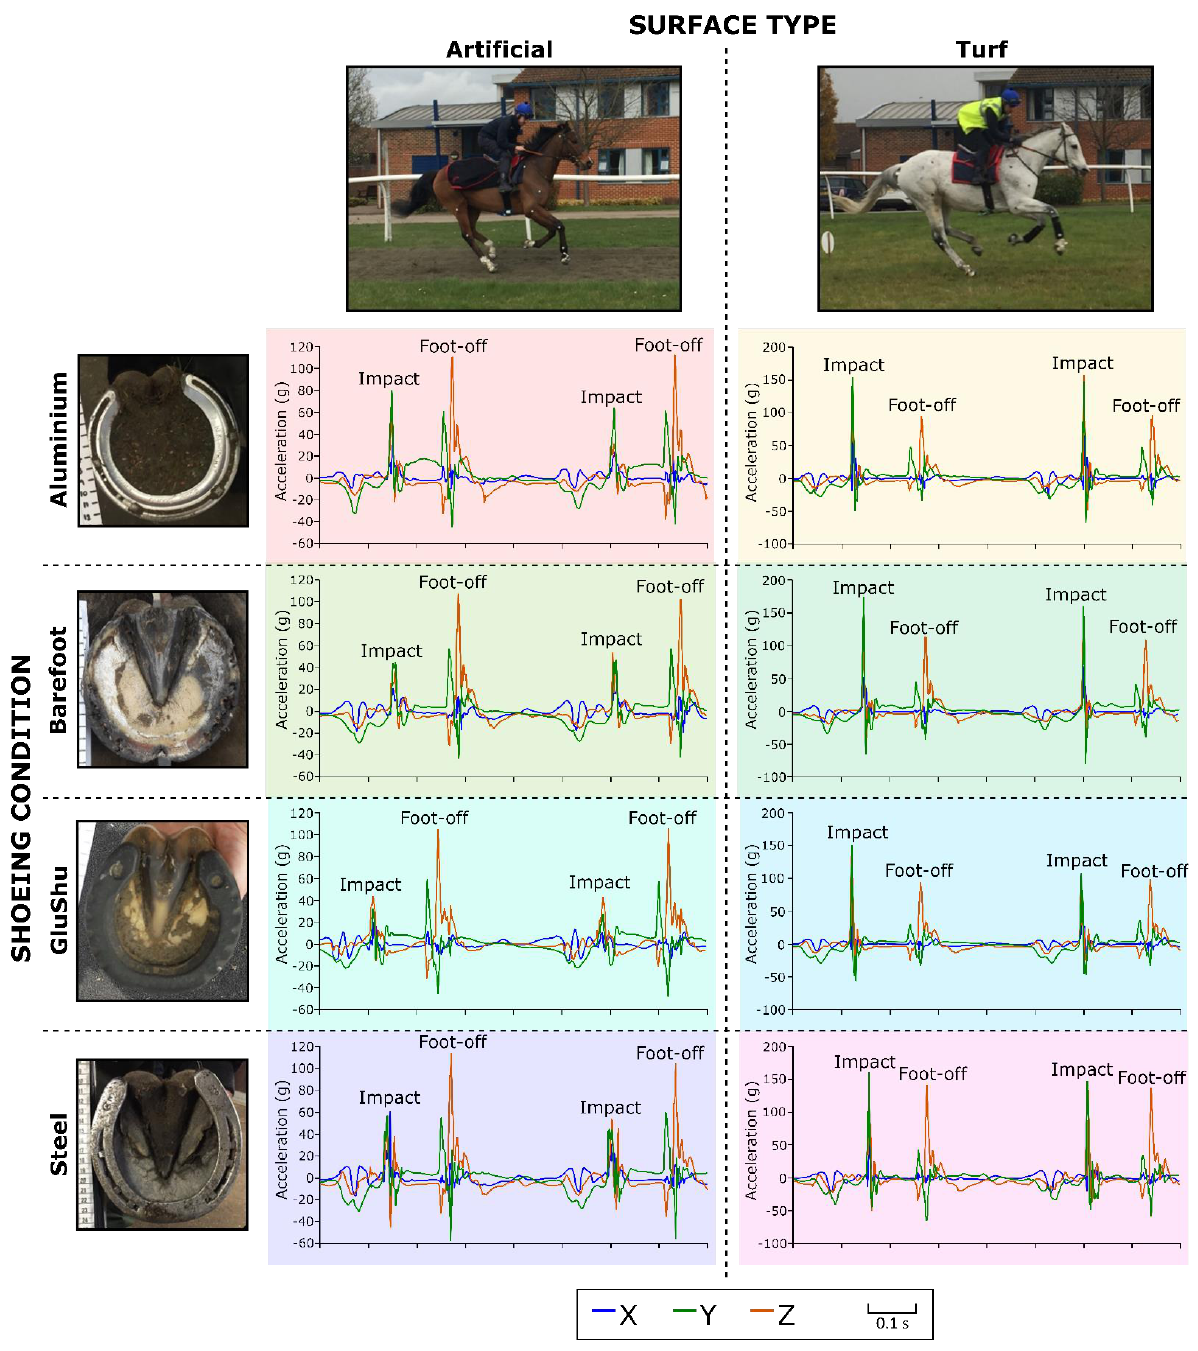
Figure 2. Examples of tri-axial accelerometry data collected from the hooves of the horse from horse–jockey combination 8 under the eight different shoe–surface combinations: x is medio-lateral, y is along the hoof wall proximo-distal and z is dorso-palmar.